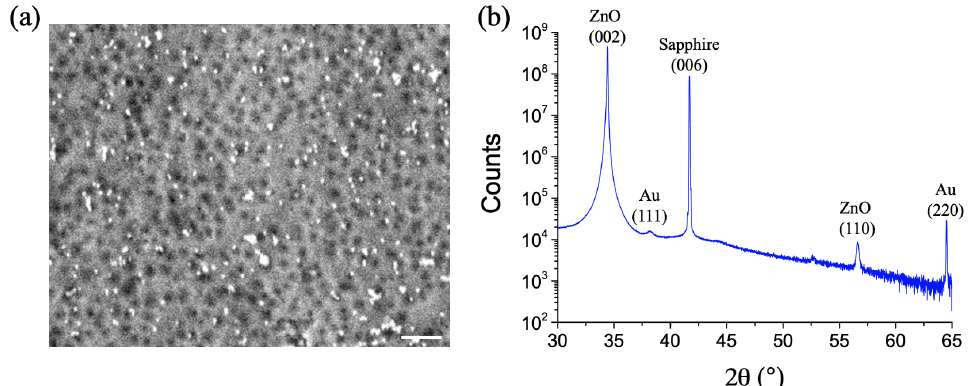
Figure 1. ( a ) SEM image of the highly crystalline ZnO film decorated with gold nanoparticles with a diameter of 30 nm (scale bar = 300 nm). ( b ) X-ray diffraction pattern recorded for the highly crystalline ZnO film with AuNPs on c-Al 2 0 3 substrate